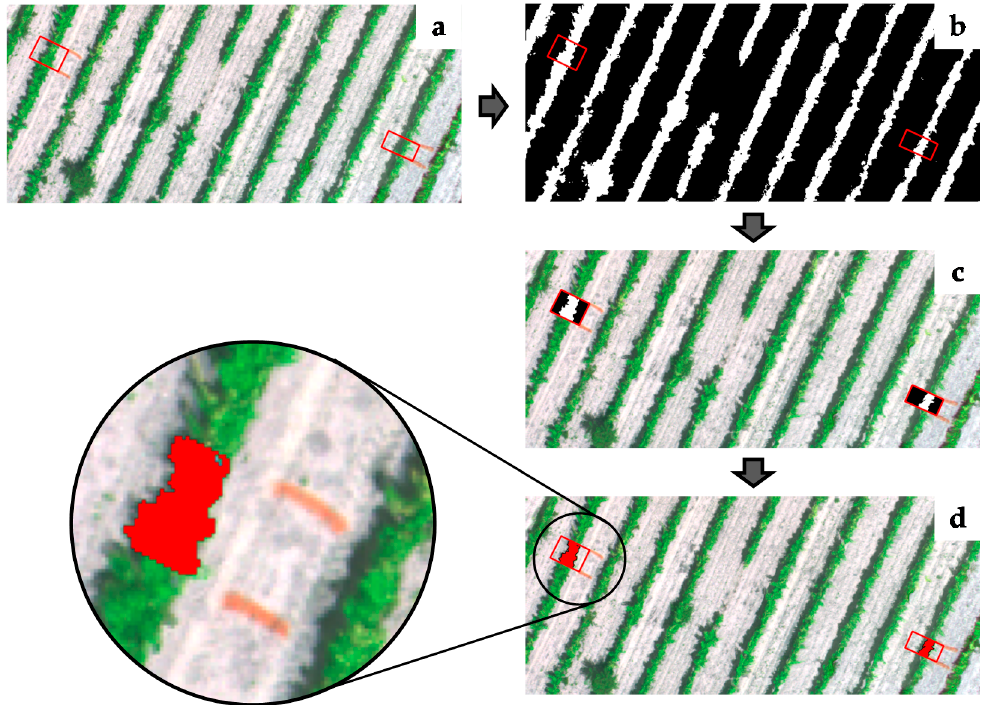
Figure 4. Overview of entire process from lime marks in ground to obtain sampling vine-only polygon contours: ( a ) polygons defining sampling vines, ( b ) binary mask, ( c ) sampling vine binary mask, ( d ) sampling vine-only polygon contours.